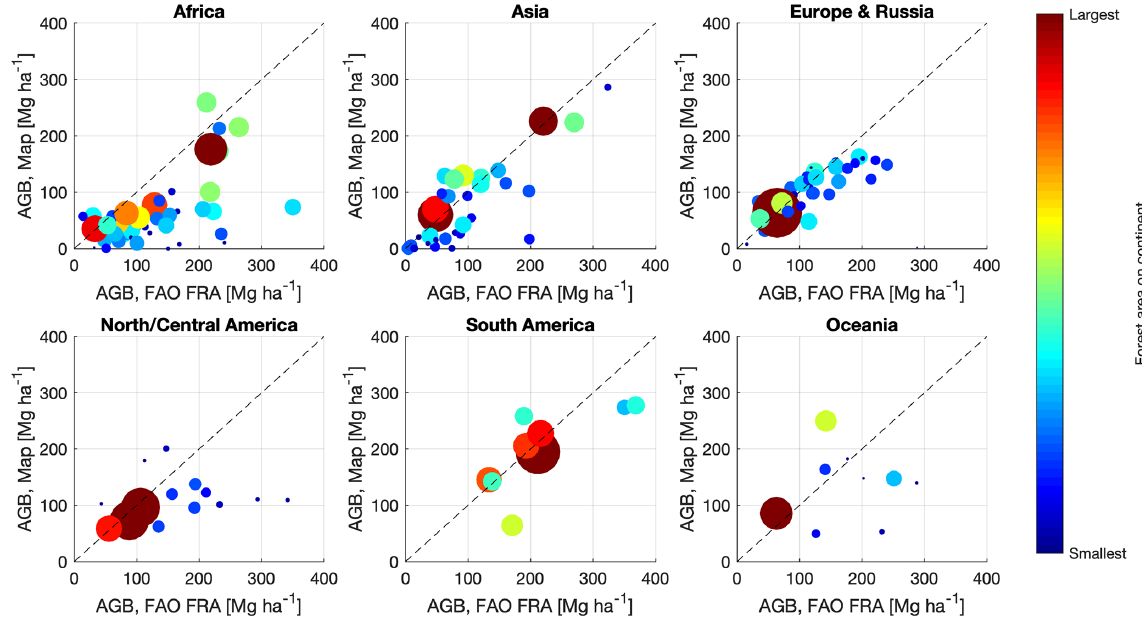
Figure 7. Average AGB per country from the FAO FRA 2010 country reports and our map dataset. Countries have been grouped per continent. The size of each circle is proportional to the forest area of the country derived from the CCI Land Cover dataset (same scaling across all continents). The colour ramp associated with the circles gives a graphical representation of the relative country forest area (different for each continent). Table 3. Total AGB (Pg) for five latitude ranges roughly corresponding to the temperate forests of the Southern Hemisphere (60–30 ◦ S), the humid and dry tropics of the Southern Hemisphere (30–10 ◦ S), the wet tropics (10 ◦ S–10 ◦ N), the humid and dry tropics of the Northern Hemisphere (10–30 ◦ N), and the temperate and boreal forests of the Northern Hemisphere (30 and 90 ◦ N). Values marked with superscript 1 indicate partial coverage of the latitude range by the corresponding map; n/a indicates not available in the latitude range. The forest area for each range is reported on the last